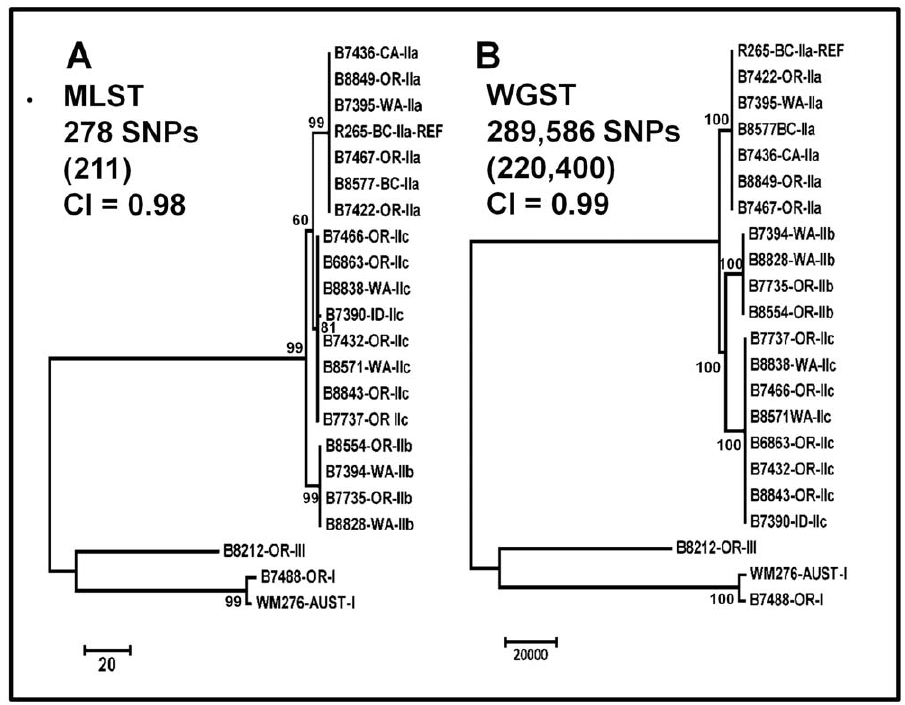
Figure 1. Phylogenetic analysis comparison of MLST and WGST data from 22 C.gattii isolates. Maximum parsimony phylogenetic analysis was performed in MEGA4 on 22 C. gattii genomes with MLST (panel A, one of 270 most parsimonious trees shown) and WGST (panel B, one of 190 most parsimonious trees shown) data. The R265 whole genome sequence was used as the reference for SNP discovery. Both trees are rooted on the VGI/VGIII branch. Bootstrap values less than 50% and for intra-VGIIa, VGIIb and VGIIc branches are not shown. The taxa nomenclature includes a four digit unique identifier, the location of origin (BC=British Columbia, CA=California, ID=Idaho, OR=Oregon and WA=Washington state), and the molecular subtype as determined by MLST analysis (I, IIa, IIb, IIc and III). The number of SNPs included in each data set is indicated (number of parsimony-informative SNPs in parentheses), as is the consistency index (CI) as calculated by MEGA4. While WGST analysis found unique genotypes for all isolates, they are not visible on this tree due to the large numbers of SNPs separating the VGII from VGI and VGIII